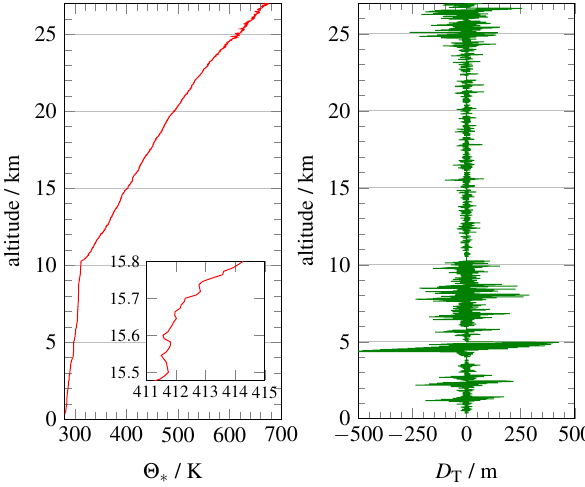
Figure 2. Potential temperature profile (left) and Thorpe displace- ment (right) for the BEXUS 12 flight. The inset in the left panel shows a magnification from 15.48 to 15.80km for better visibility of instabilities (manifested as negative gradients of potential tem-